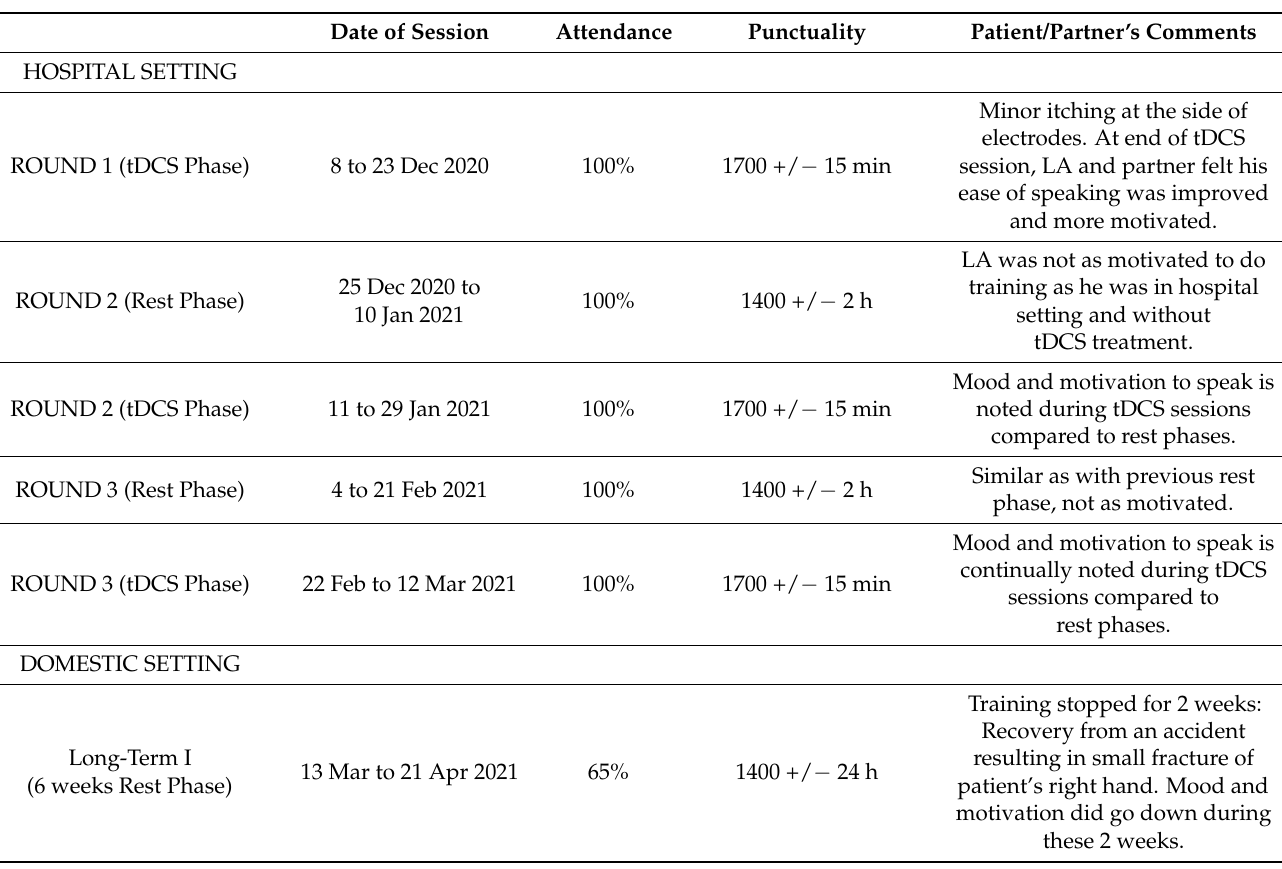
Table A1. Adherence during the different therapy phases. During hospital setting, tDCS phases (labeled tDCS) were performed at the hospital, while rest phases (labeled “rest”) took place at home. During the home setting, all phases took place at home. Note that the patient described improved mood and motivation during the stimulation